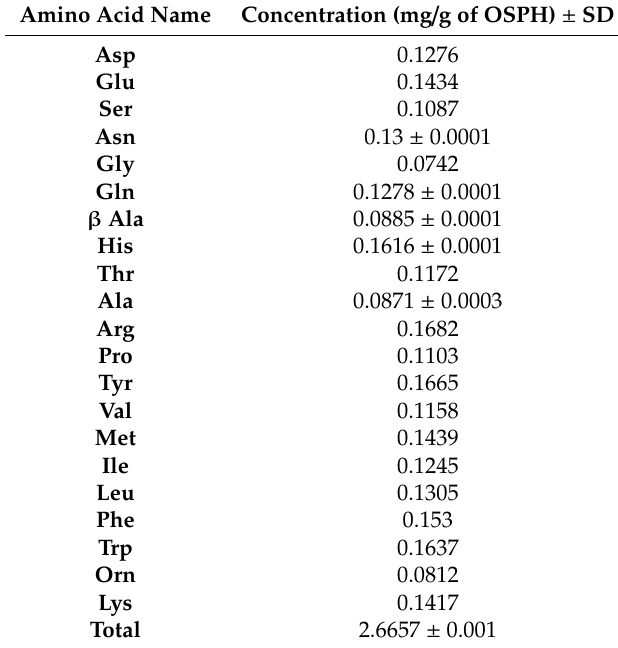
Table 1. Free amino acid composition of orange seed protein